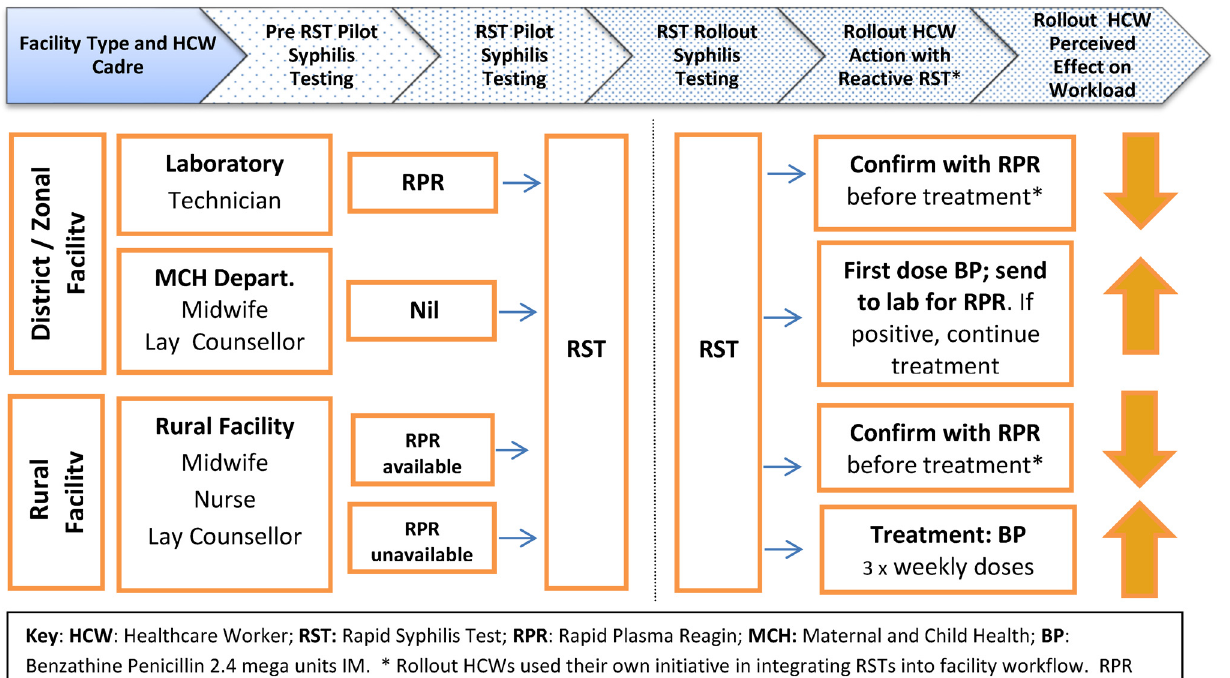
Fig 3. Changes in Syphilis Testing before and after RST introduction and perceived effect on workload for different HCW cadres in Zambia. HCW : Healthcare Worker; RST: Rapid Syphilis Test; RPR : Rapid Plasma Reagin; MCH: Maternal and Child Health; BP : Benzathine Penicillin 2.4 mega units IM. * Rollout HCWs used their own initiative in integrating RSTs into facility workflow. RPR confirmation was often done immediately where RPR was available and performed by the same HCW performing